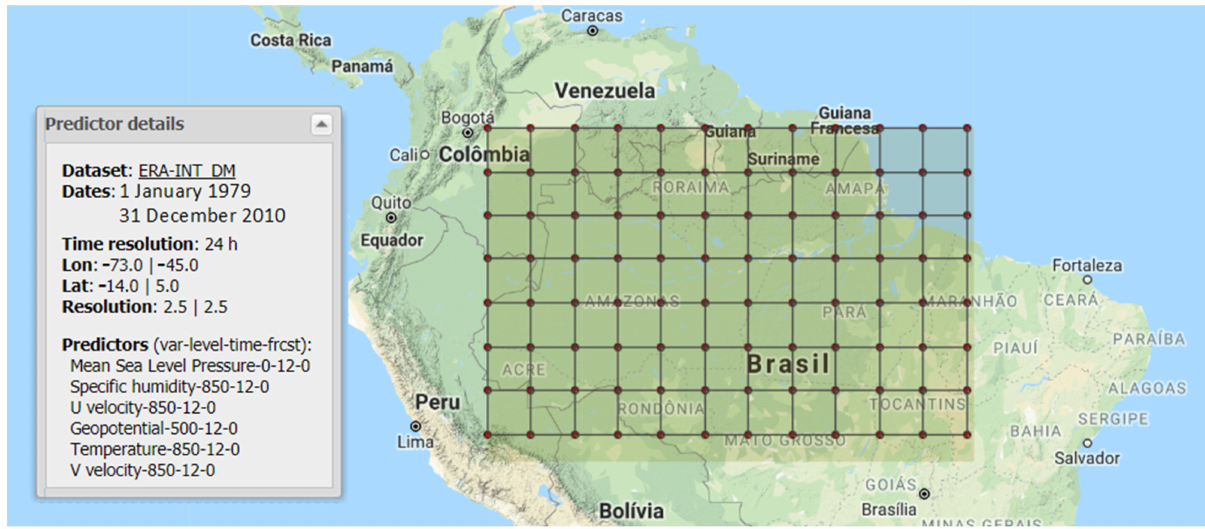
Figure 2. Resolution grid over the Amazonian area used to establish the relations between predictor (reanalysis) and predictand (surface observations)